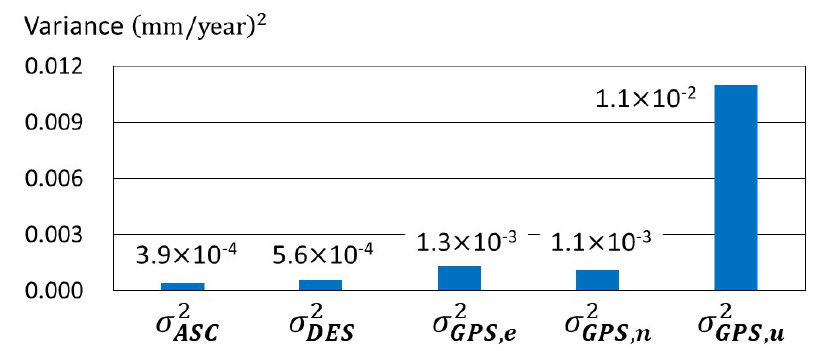
Figure 8. Variances of velocity derived from PSI and obtained from GPS